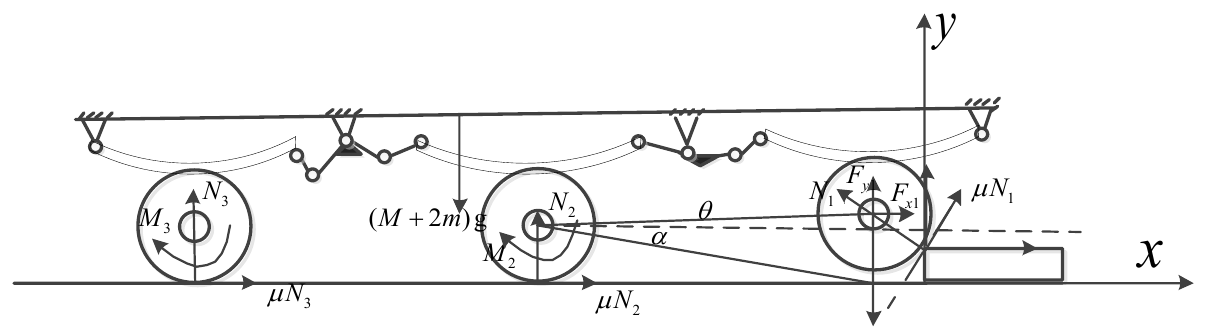
Figure 8. Obstacle-surmounting dynamic model of obstacle-surmounting wheel.